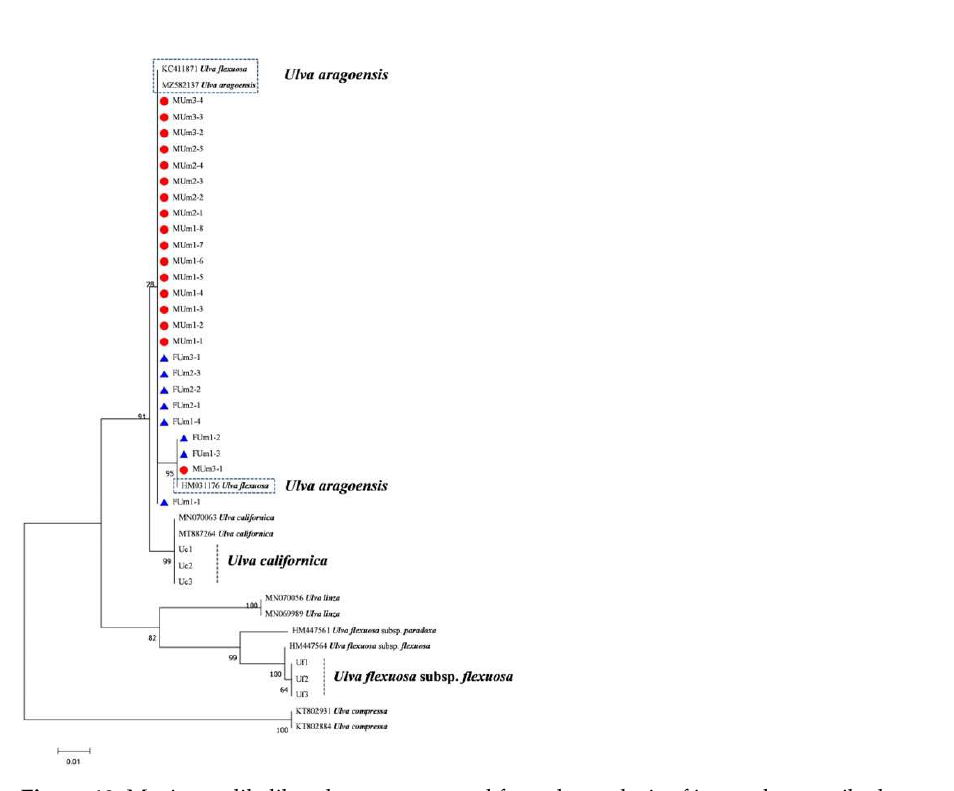
Figure 10. Maximum likelihood tree constructed from the analysis of internal transcribed spacer gene sequences of U. aragoensis samples and those downloaded from GenBank.